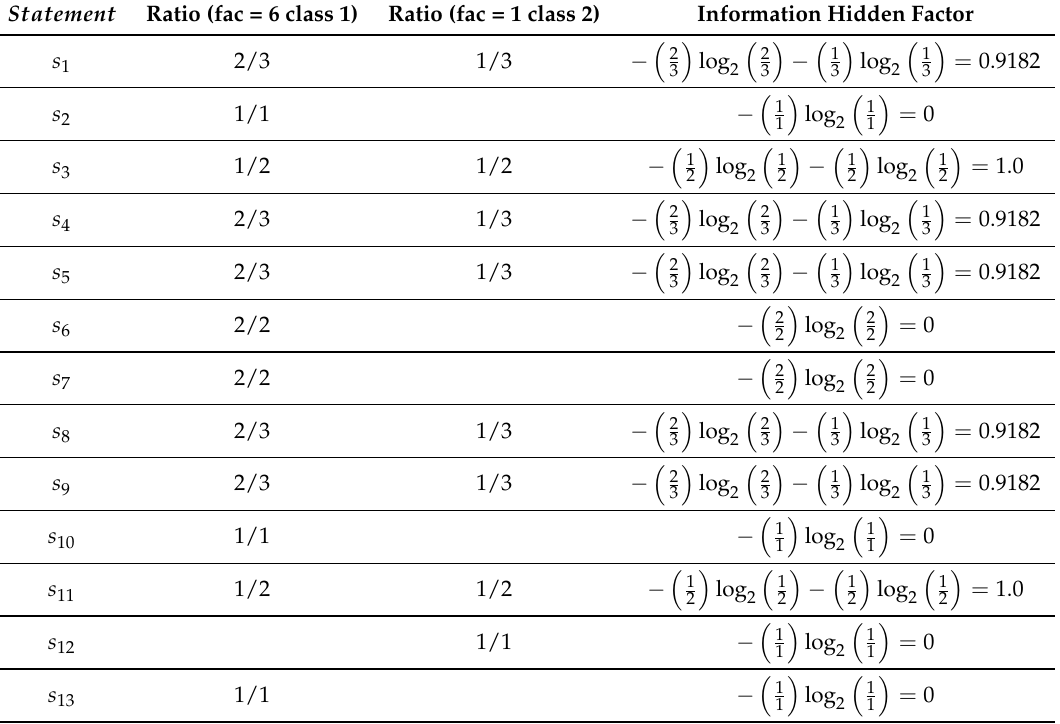
Table 7. Computation for information hidden factor of each statement in Program